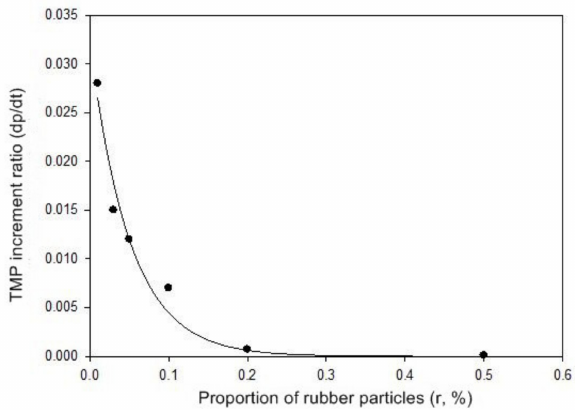
Figure 4. TMP increment ratio (dP/dt) versus waste rubber particle addition to MBR. Regression was conducted using the exponential equation [dP/dt = dp 0 /dt · EXP (-k · r)]. The pressure drop coefficient, k, was 19.76, while r represents the proportion of rubber particles (%, V/V) in the reactor. The R-square and p -value of the regression line were 0.97 and 0.0005,